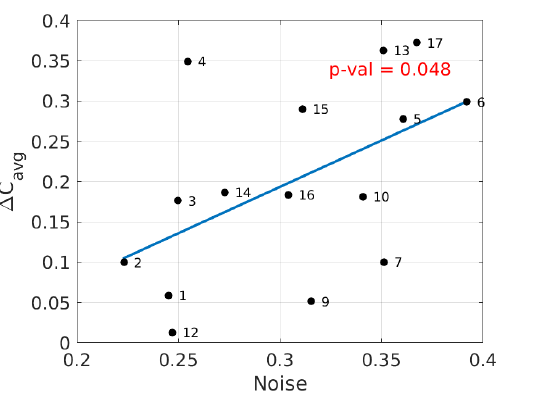
Figure 3. Average event-related coherence in the visual cortex versus estimated brain noise to phase synchronization. The straight line is a linear regression fit of the data ( p = 0.048, R 2 = 0.267).